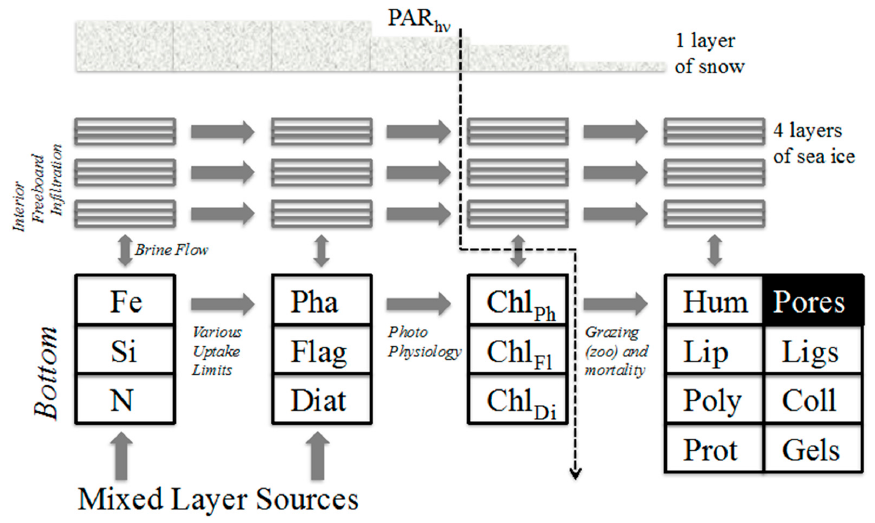
Figure 2. Schematic of the ice organic biogeochemistry mechanism in the present work. Major ecodynamic channels described anecdotally in the text and as equations in an appendix. Abbreviations: (Diat) generic diatoms, (Flag) microflagellates, (Pha) Phaeocystis, (Chl) chlorophyll content for each class, (Prot) Proteins, (Poly) carbohydrates or polysaccharides, (Lip) the broad class of lipids, (Hum) the heterogeneous polymers humic acid, (Coll) colloids forming from the organics, (Ligs) Ligand effects which can become important under trace metal limitation, (PAR) Photosynthetically Available